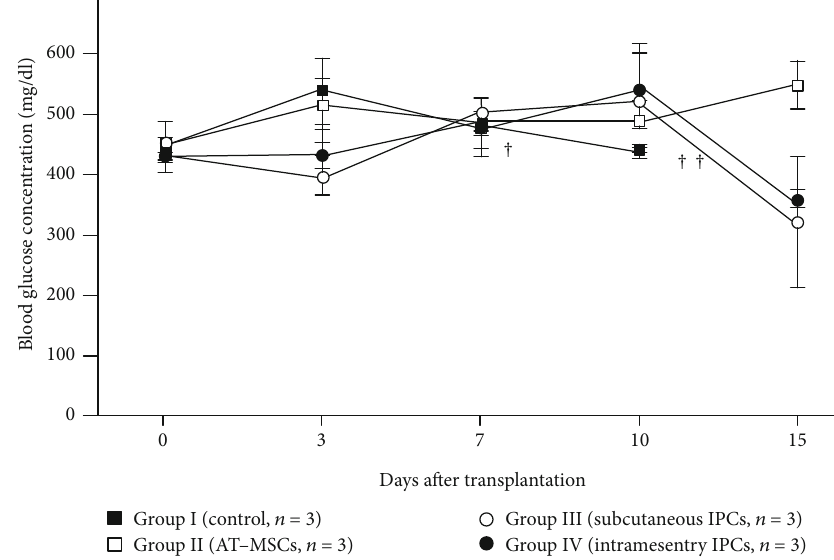
Figure 6: Nonfasting blood glucose levels after transplantation. The blood glucose levels at day 15 were decreased in groups III (subcutaneous IPC transplantation) and IV (intramesentery IPC transplantation) compared with group II (AT-MSC transplantation), but the hyperglycemic state was not improved. † : death in group